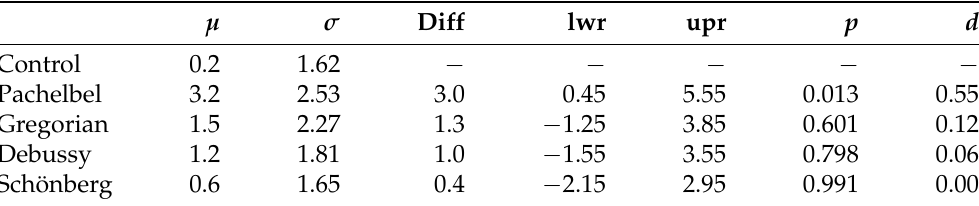
Table 2. Tukey post-hoc results for the multiple comparisons from the ANOVA between the control group and the listening conditions: Pachelbel, Gregorian, Debussy, and Schönberg. The mean ( µ ) and standard deviation ( σ ) of the difference between pre- and post-condition per sample, mean differences (Diff) with respect to the control group, lower and upper confidence intervals (lwr and upr), p -value, and Cohen’s d are